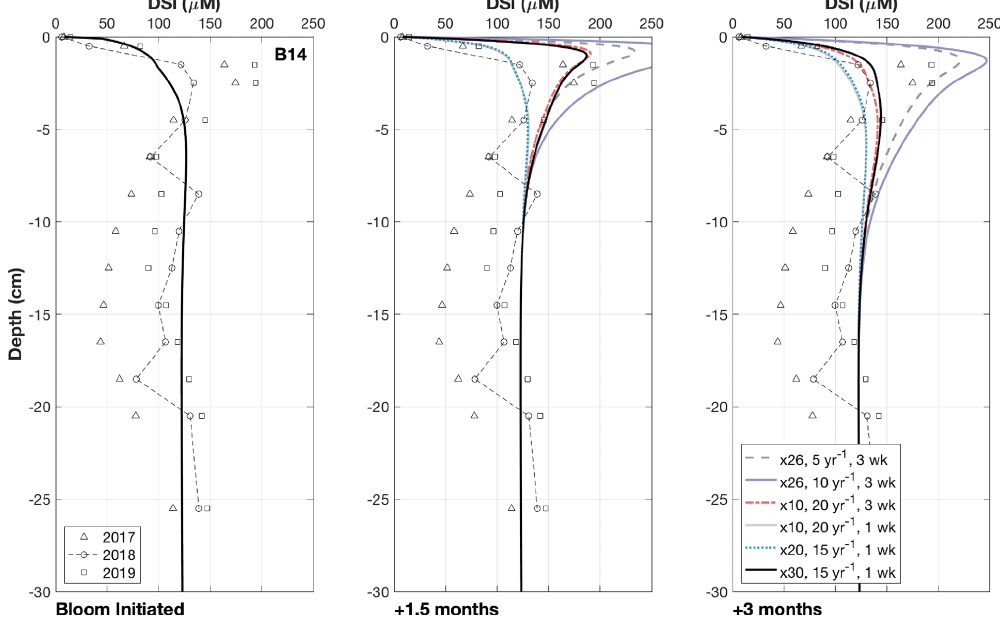
Figure 4. Results of the transient simulations under different conditions. Multiplier refers to the increase in the deposition flux ( J BSi , in ) of the bloom-derived BSi, which was assigned a reactivity ( k dissbloom in yr − 1 ) and deposited over either 1 or 3 weeks. Note that the “Bloom Initiated” panel represents the first day of the simulated bloom; therefore all the modelled scenarios overlap and reflect the background steady state simulation. The panels “ + 1.5 months” and “ + 3 months” refer to the time elapsed since the bloom was initiated, which are presented to demonstrate how the DSi peak evolves over time. Ward et al. (2022) suggested that DSi peaks could form within 1.5 months and dissipate after 3 months, as evidenced by contrasting sea ice conditions across the three